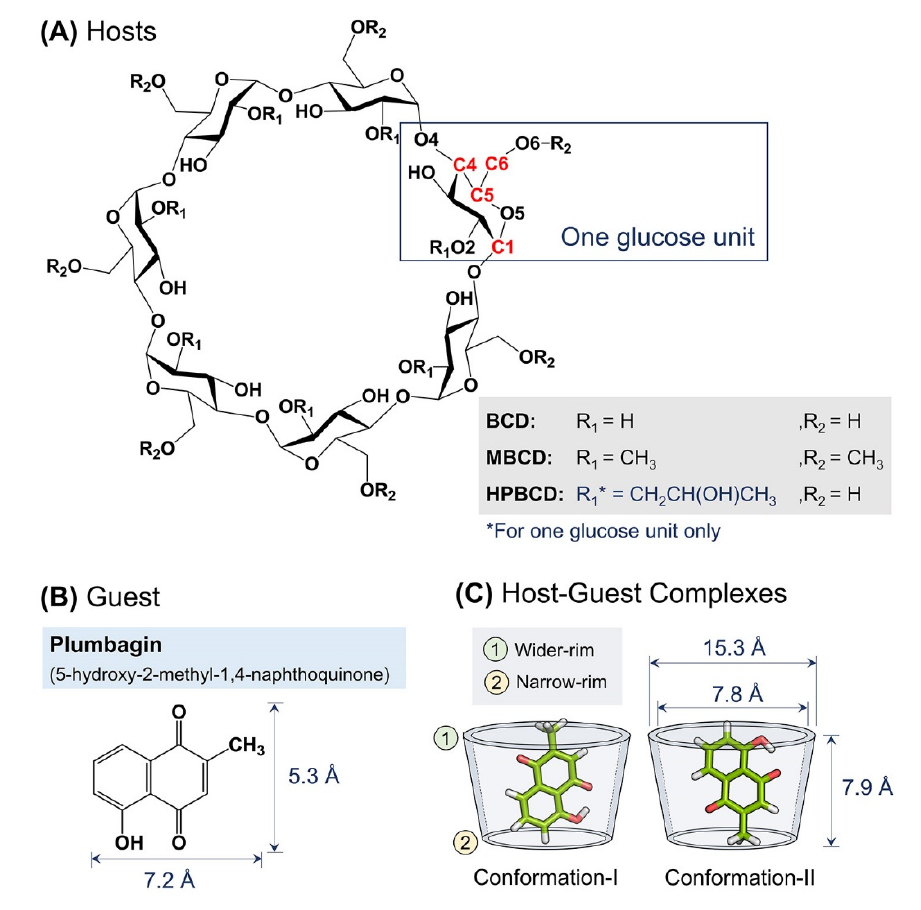
Figure 8. Schematic representations of: ( A ) Glucose unit and atomic numbering of BCD, MBCD, and HPBCD. ( B ) Plumbagin structure and its dimensions. ( C ) Two major conformations of plumbagin–BCDs inclusion complexes and BCD’s dimensions.